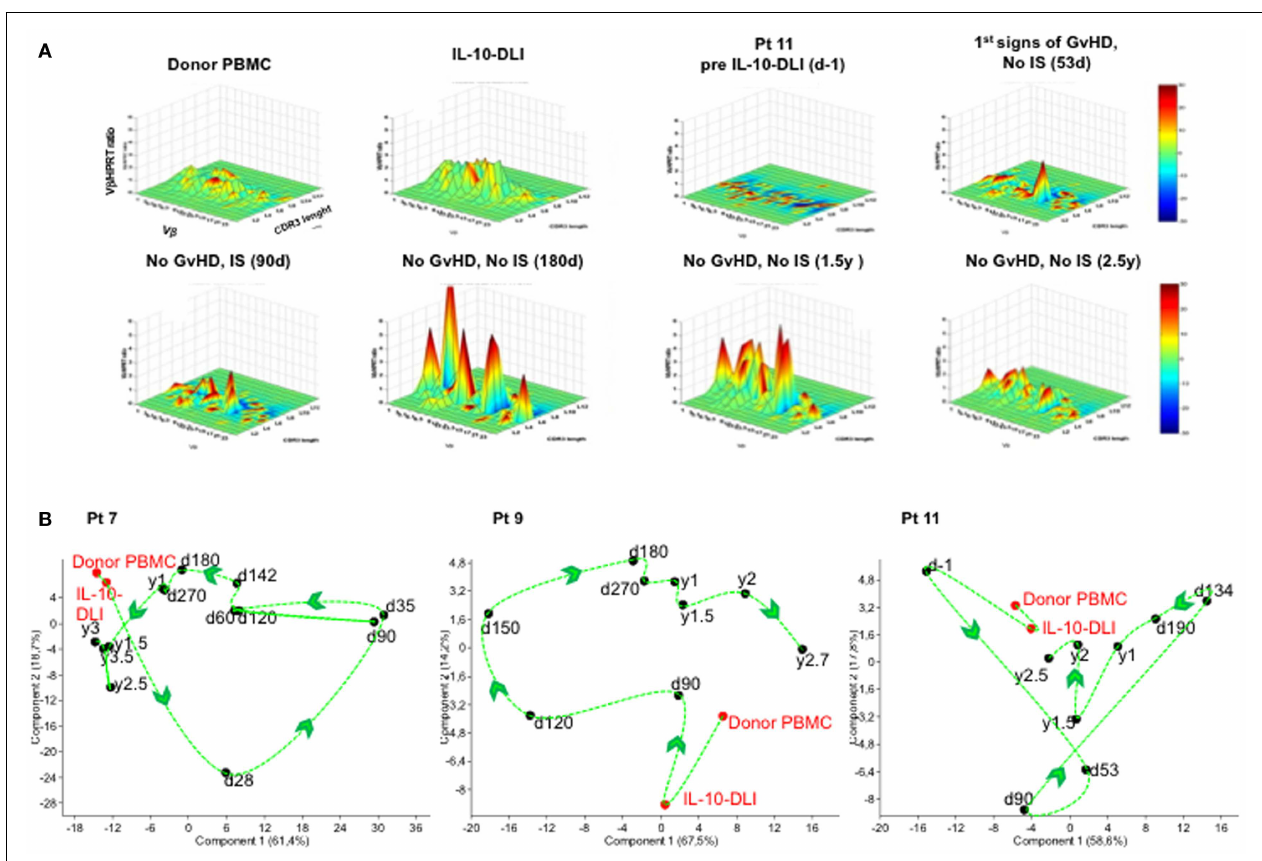
years. (B) TCR repertoire analysis. Evolution ofV β gene-expression of each patient by Principal Component Analysis (PCA). PCA allows projection of the different time-points in a factorial space defined by axes, named “components,” which are linear combinations of optimally weighted observed variables.The distance between two time-points is related to theirTcLandscape similarity. For each patient, the percentages of eachV β family for all recipient time-points, were independently analyzed by PCA. The “itinerary” taken by theTCR repertoire of the patient duringT-cell reconstitution is shown by a dashed curve and arrows. Pt: patient; IL-10-DLI: IL-10-anergized donorT cells infused into the patients; d: days; y: